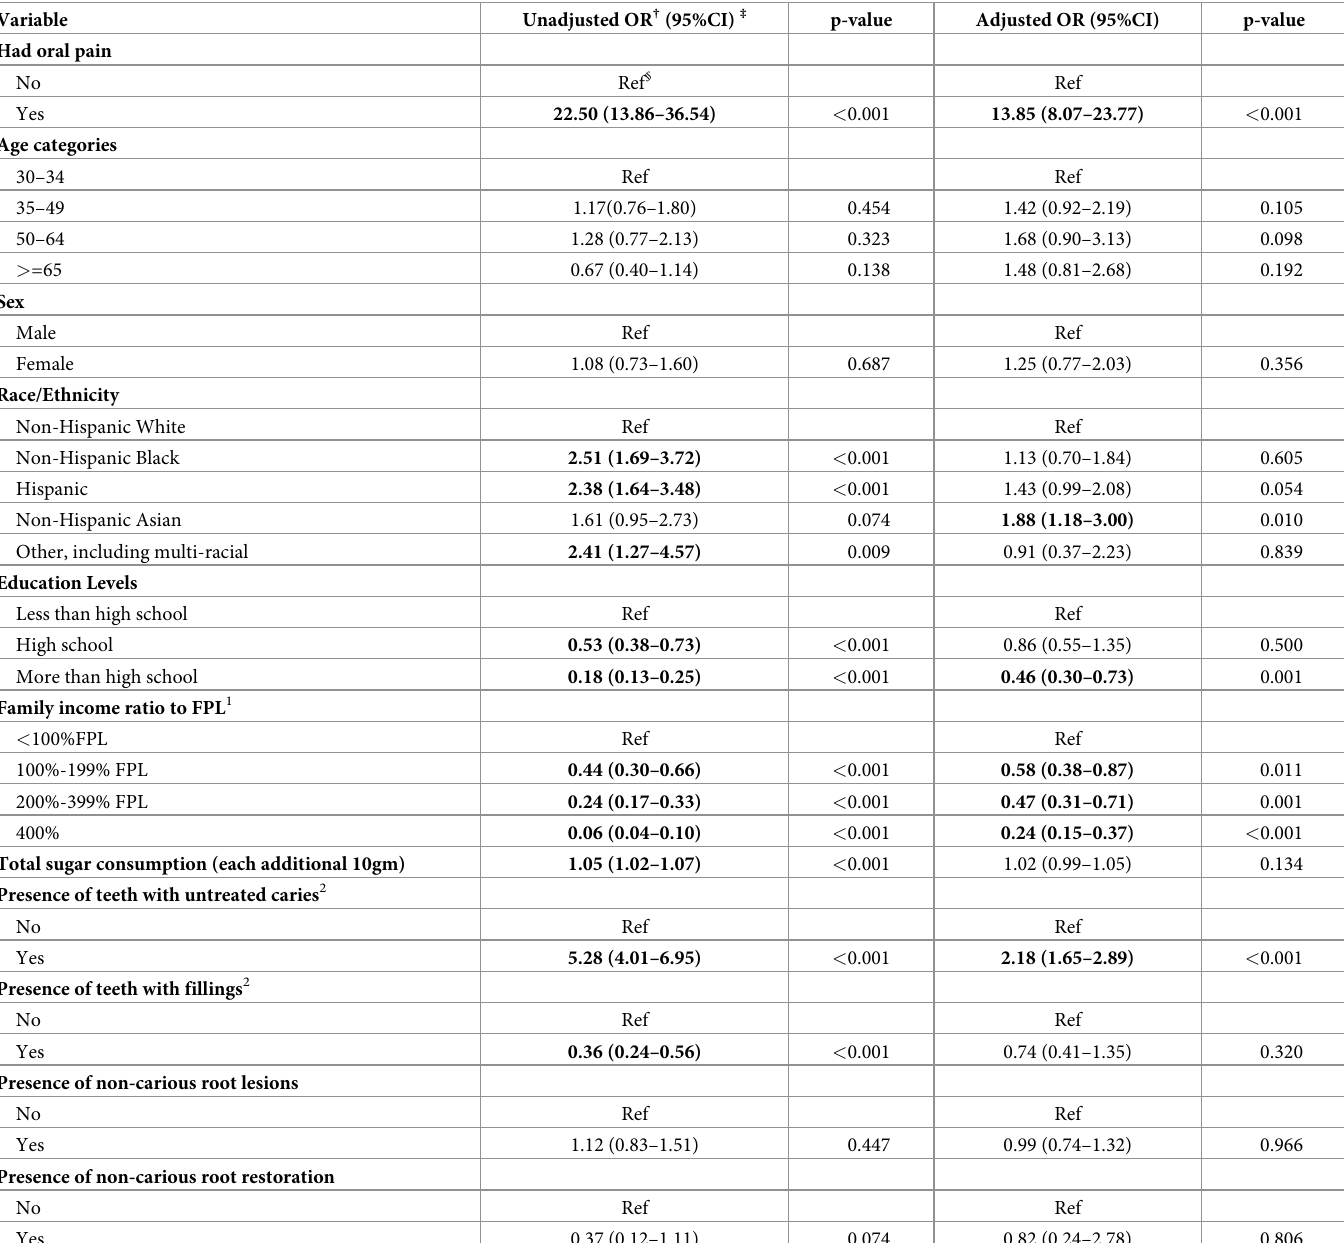
Table 4. Logistic regression models of associations between oral-related productivity loss last year and individual characteristics among adults aged � 30 years who completed the dental examination and at least the first 24-hour dietary recall interview, had at least one natural tooth, and provided an answer about oral-related productivity loss in the National Health and Nutrition and Examination Survey (NHANES);